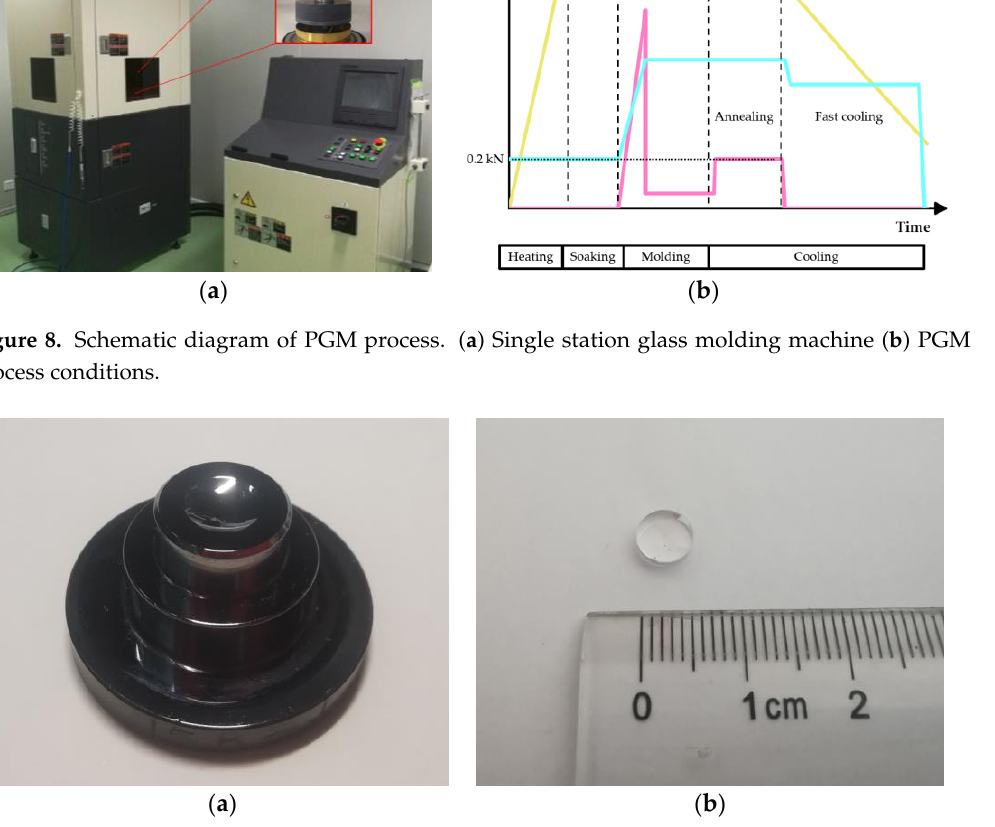
Figure 9. The mold used in PGM experiment and molded glass lens. ( a ) Fine grinding mold and ( b ) molded glass lens.